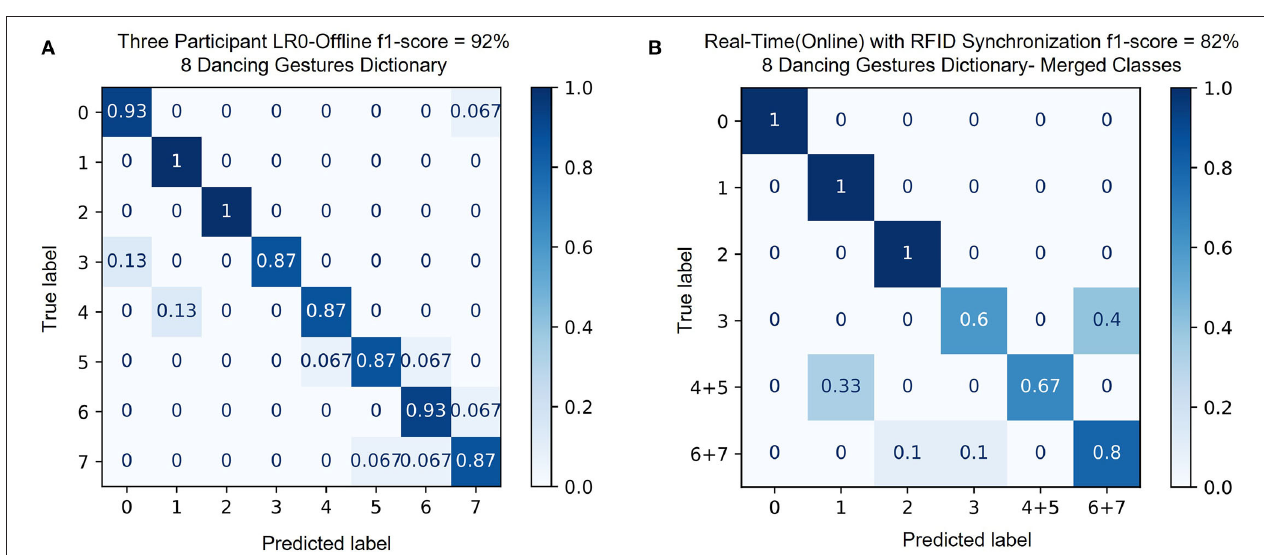
FIGURE 9 | Group model evaluation results. (A) Confusion matrix for the offline test results with Leave-recording out (LRO) for three participants. (B) Confusion matrix for the online results using the RFID synchronization method for one